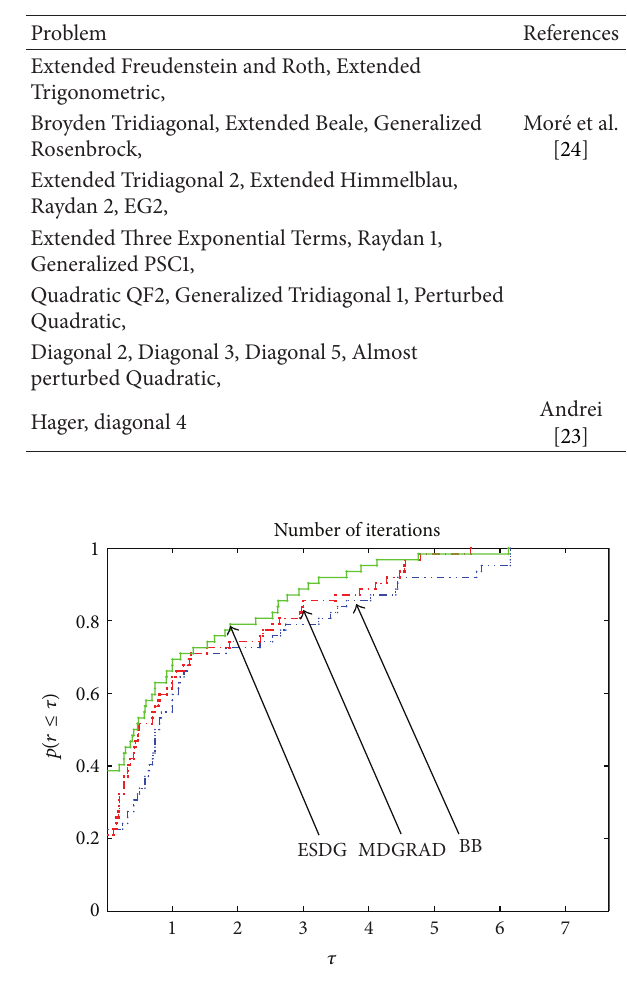
Figure 1: Performance profile based on